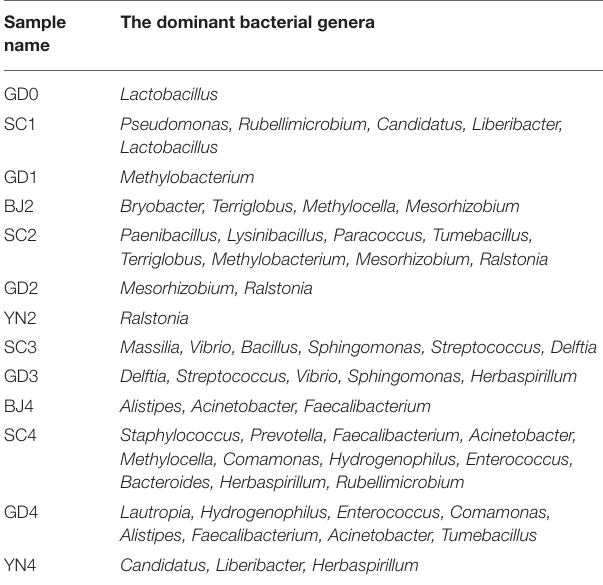
TABLE 4 | Distribution of the dominant bacterial genera in all